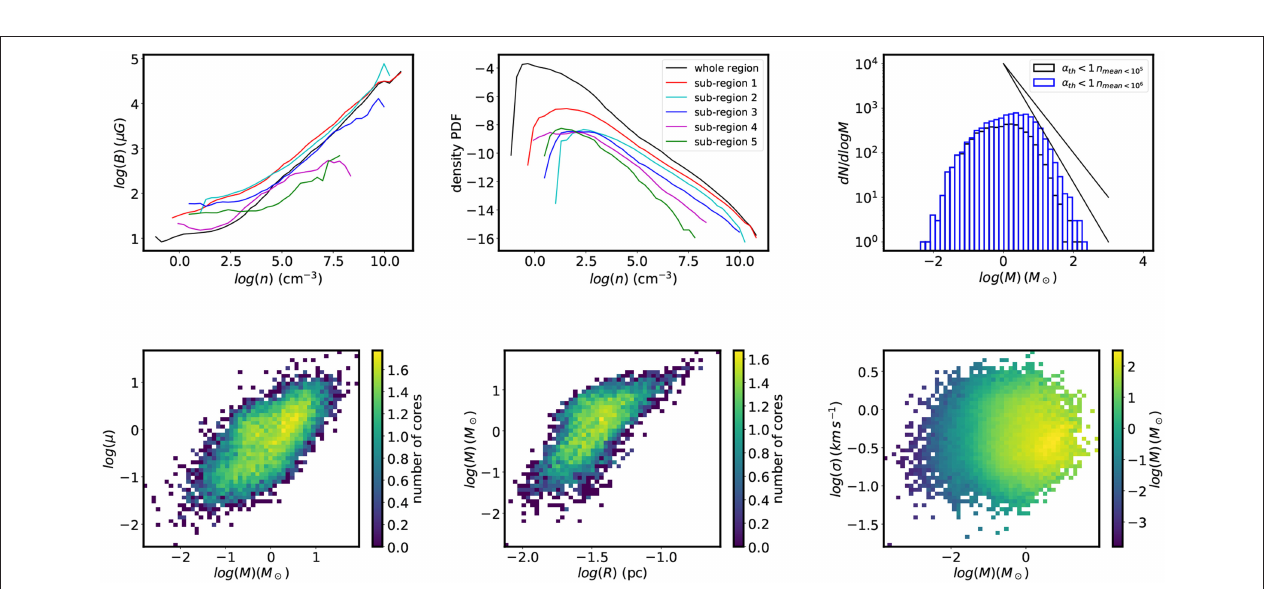
10 − 3 pc resolution (Hennebelle, 2018). ×